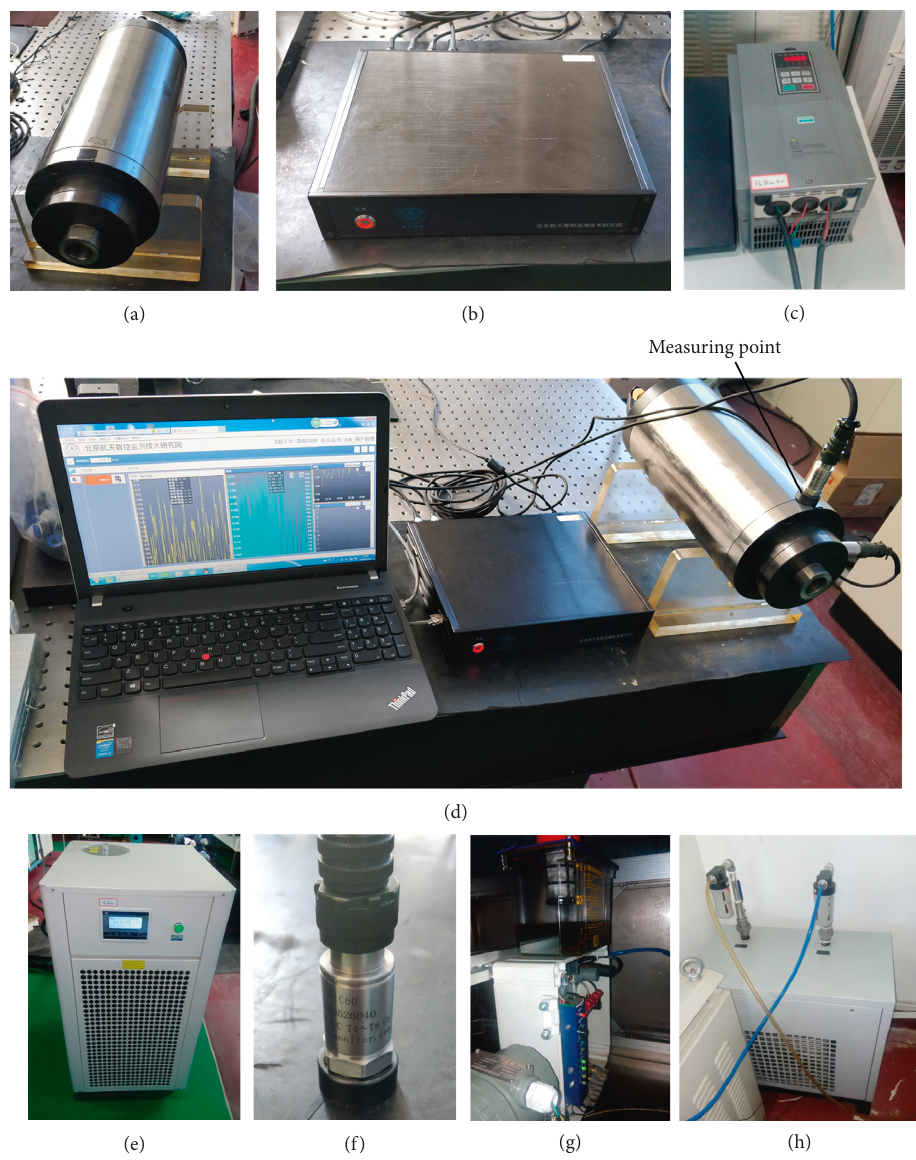
Figure 7: Experimental devices: (a) ceramic spindle; (b) data collector; (c) controller; (d) test rig; (e) water cooling system; (f) vibration sensor; (g) oil lubrication; (h) air